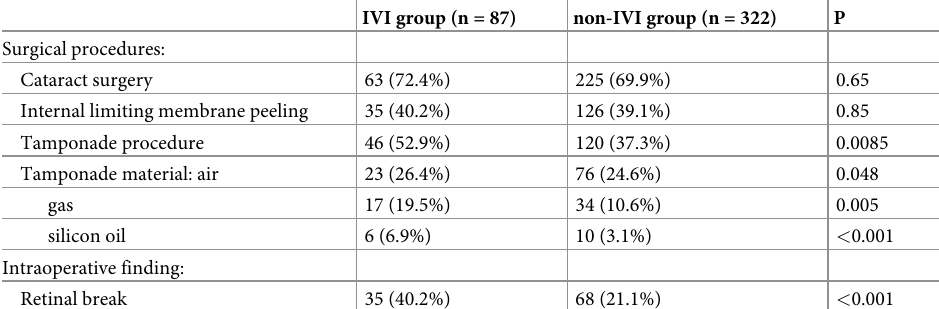
Table 2. Surgical procedures and intraoperative finding in two groups. Surgical